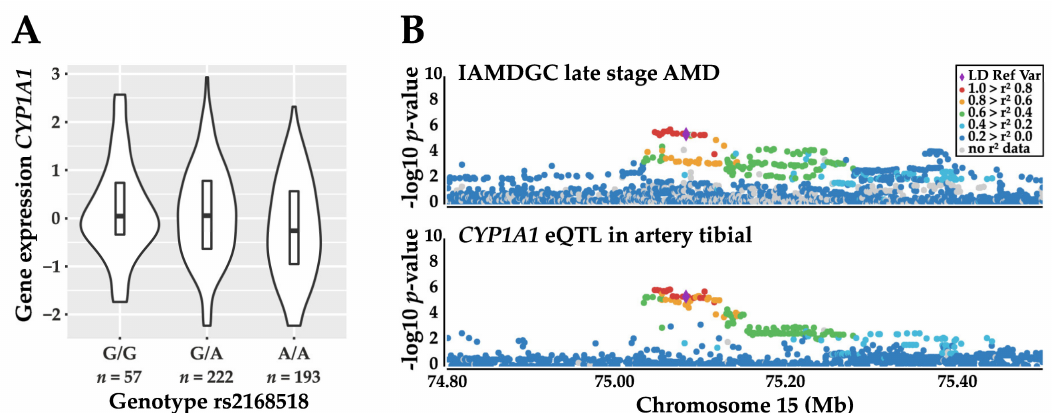
Figure 4. Expression quantitative trait locus (eQTL) analysis reveals CYP1A1 as a potentially regulated gene by the AMD-associated variant rs2168518. ( A ) As an example, the significant eQTL gene (eGene) CYP1A1 is di ff erentially regulated by rs2168518 in artery tibial tissue and ( B ) colocalizes with the genetic association signal of AMD. Manhattan Plots were created with Locuszoom